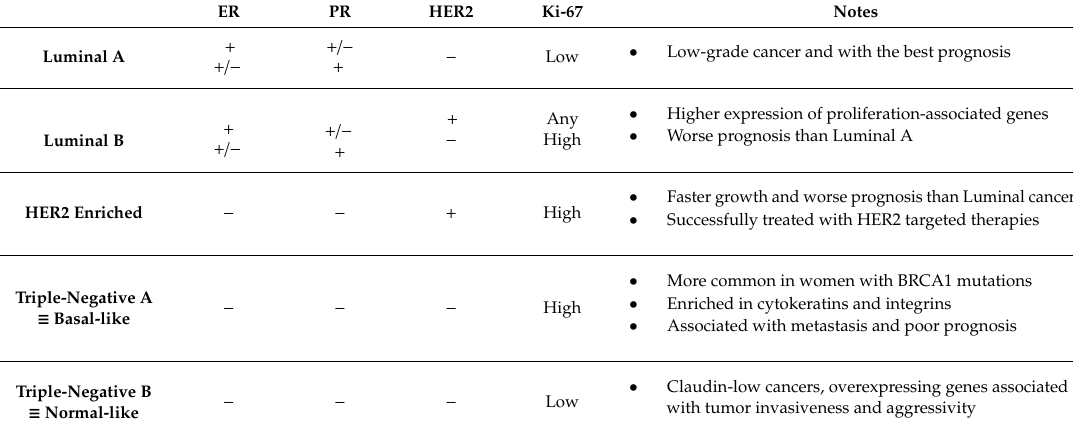
Table 1. Molecular classification of breast cancer based on Estrogen Receptor (ER),